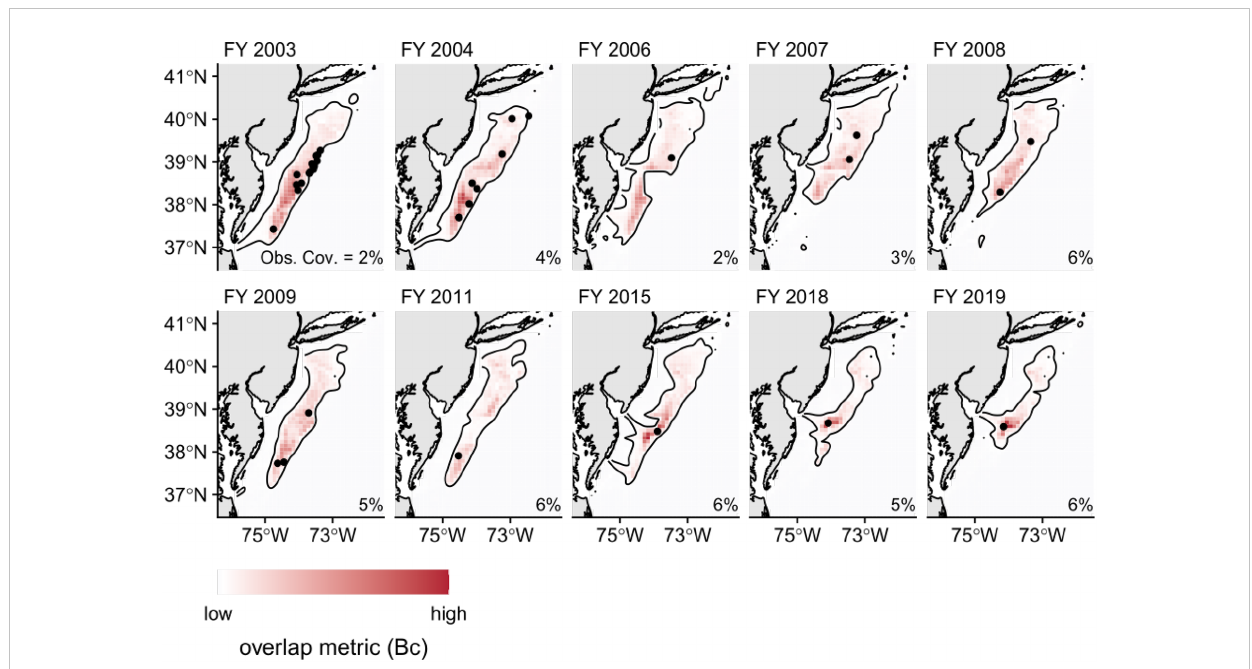
FIGURE 4 Maps of averaged overlap values across months by fi shing year (FY) for years where observed interactions occurred. Superimposed, as black dots, are the corresponding observed interaction locations between loggerhead turtles and the U.S. Atlantic sea scallop fi shery. The black, contour line corresponds to the lowest value of the averaged overlap metric associated with an observed location of loggerhead turtle interaction across all years. The observer coverage (Obs. Cov.) for the corresponding calendar year is listed in the lower, right-hand corner of the maps and were extracted from Murray (2011); Murray (2015); Murray (2021).